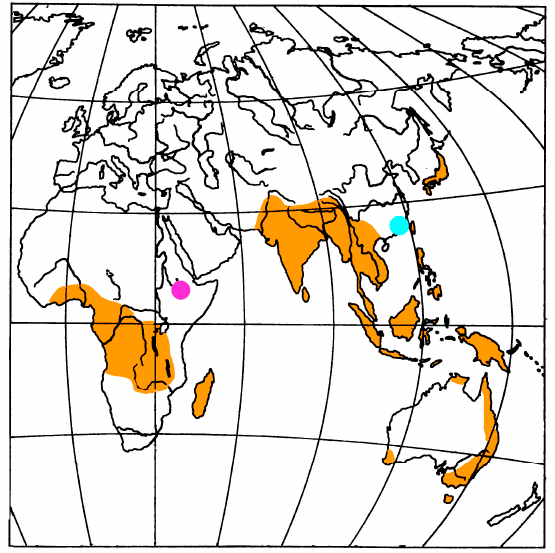
Figure 7. Distribution of Diapodini. Fossil records: pink sphere—Ethiopian amber, light blue sphere—Zhangpu